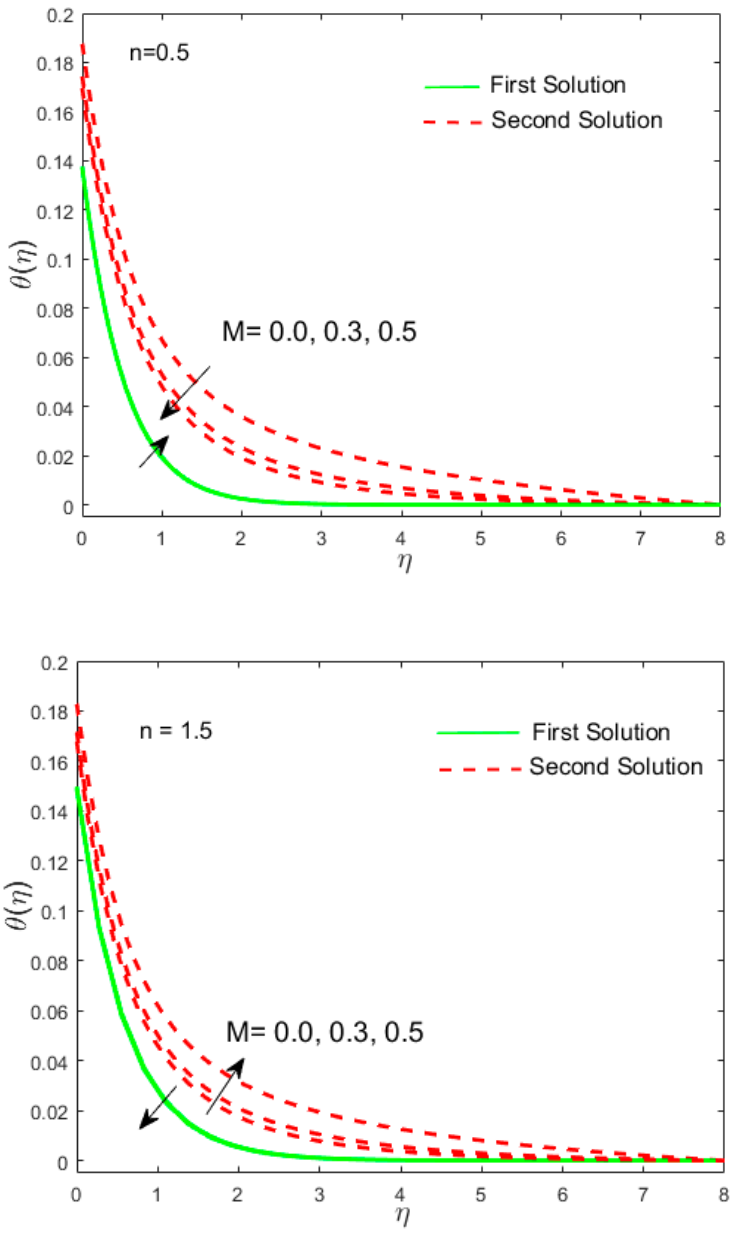
Figure 7. Influence of M on θ ( η )